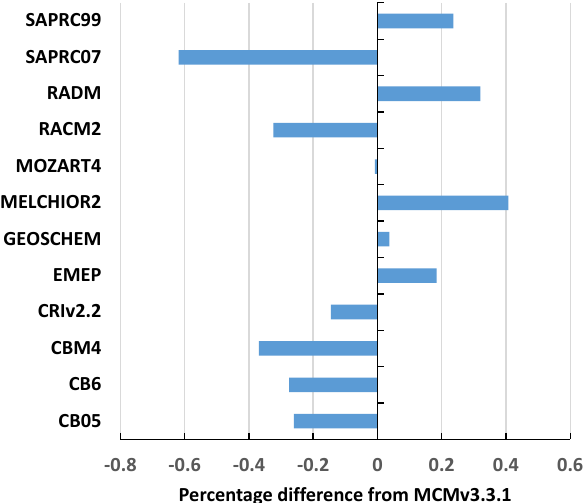
Figure 1. Average percentage differences from the MCMv3.3.1 in the base case ozone production rates in ppb per hour across the 108 sets of background conditions. [OH] for the MCMv3.3.1 varied from 0.3 to 3.6 × 10 6 molecule cm −3 , with an average of 1.6 × 10 6 molecule cm −3 . Again, [OH] values were closely similar between the different chemical mechanisms.